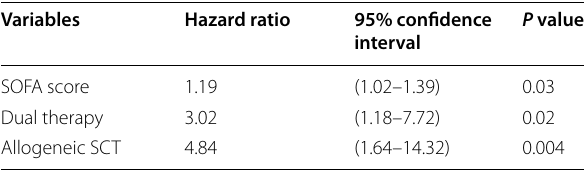
SOFA sequential organ failure assessment, SCT stem cell transplantation